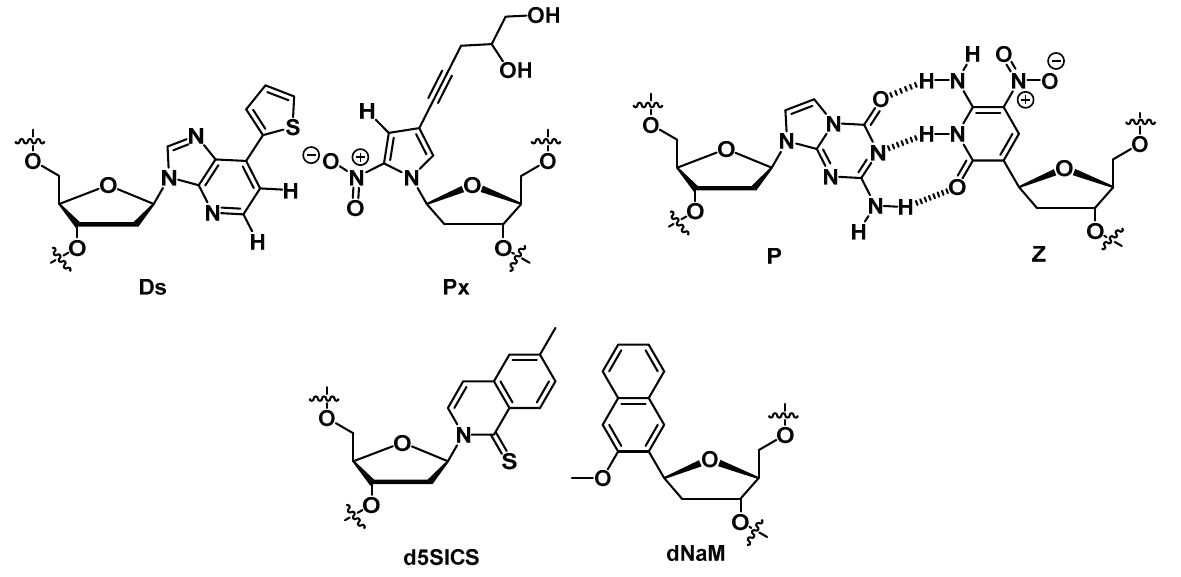
Figure 7. The structures of the unnatural Ds : Px , P : Z , and d5SICS : dNaM base